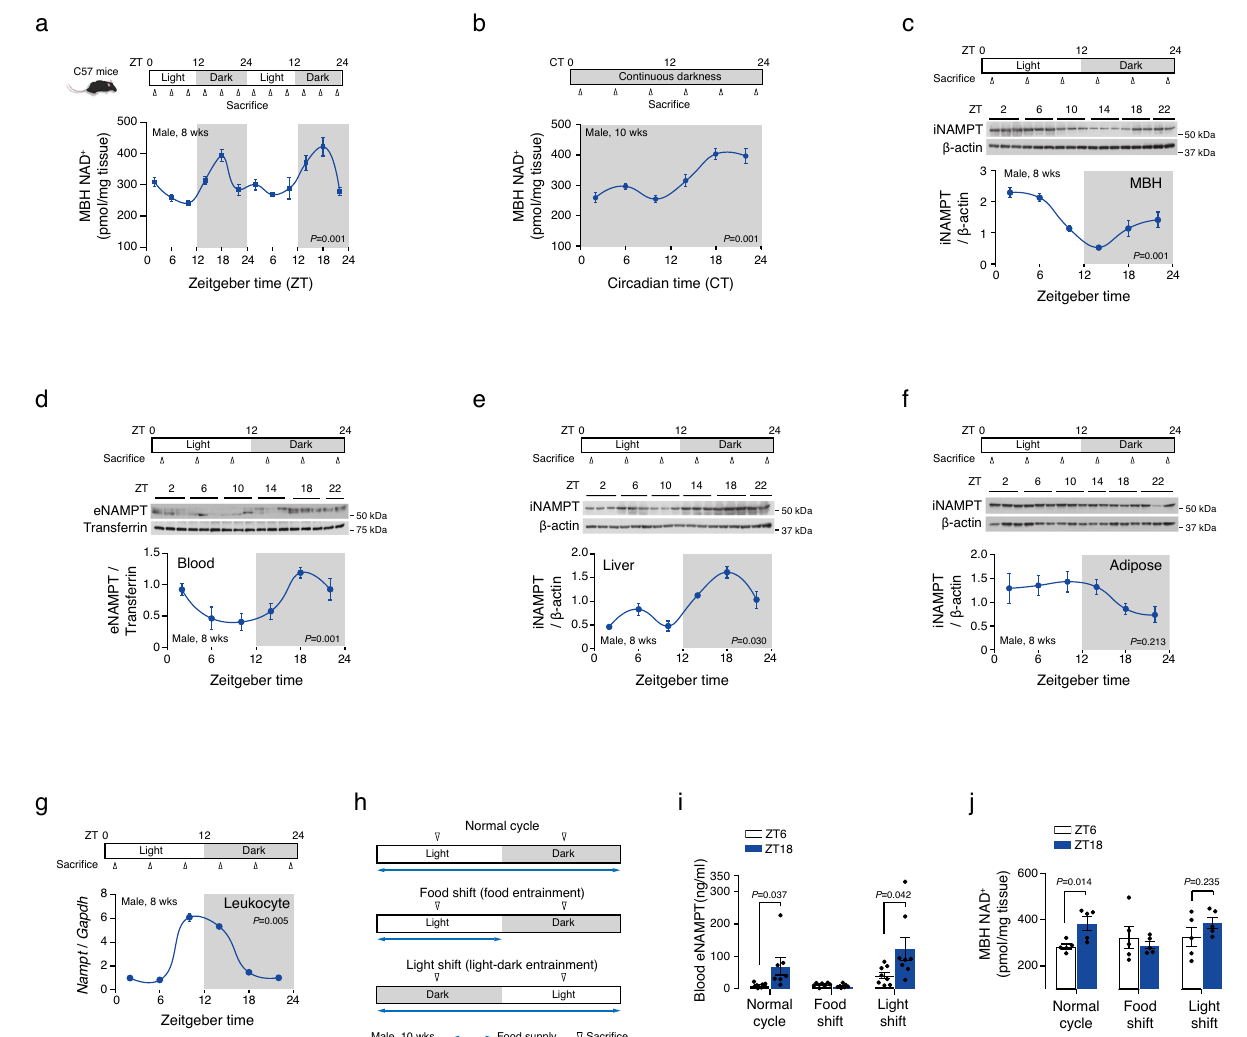
Fig. 1 | Nocturnal rhythmic elevation of hypothalamic NAD + levels is in phase with that of plasma eNAMPT. a Circadian fl uctuation in the NAD + levels of the mediobasal hypothalamus (MBH) throughout two consecutive 12 h-light/dark cycles in 8-week-old mice ( n =5 mice). P values was determined using JTK-cycle algorithm. b Circadian fl uctuationintheMBHNAD + levelsinmiceafterexposureto 2-week continuous darkness (CT18, n =4; other time groups, n =5 mice). P values was determined using JTK-cycle algorithm. c − f Circadian oscillations in plasma eNAMPT( d )andtheiNAMPTlevelsinthemediobasalhypothalamus(MBH, c ),liver ( e ), and epididymal adipose tissues ( f ) in mice subjected to a 12-h light/dark cycle (plasma, MBH and liver ZT22, n =2; adipose tissue ZT14, n =2; other groups, n =3